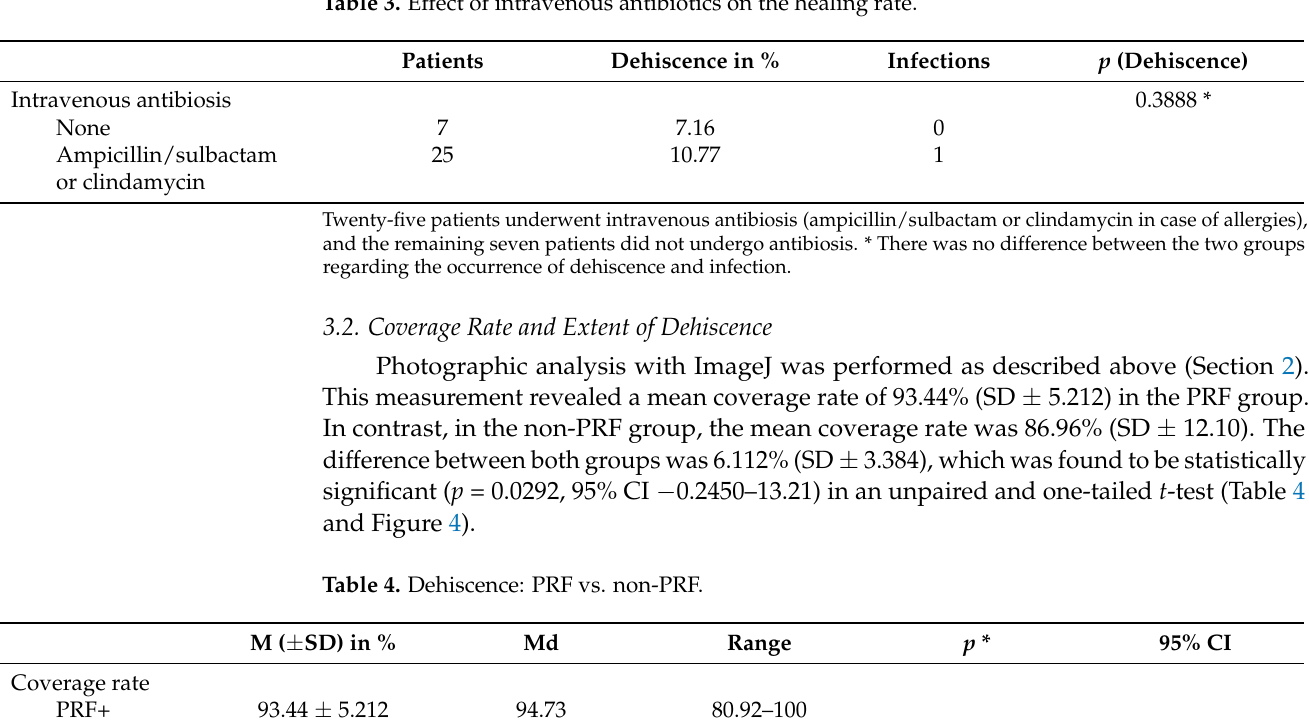
Table 3. Effect of intravenous antibiotics on the healing rate.